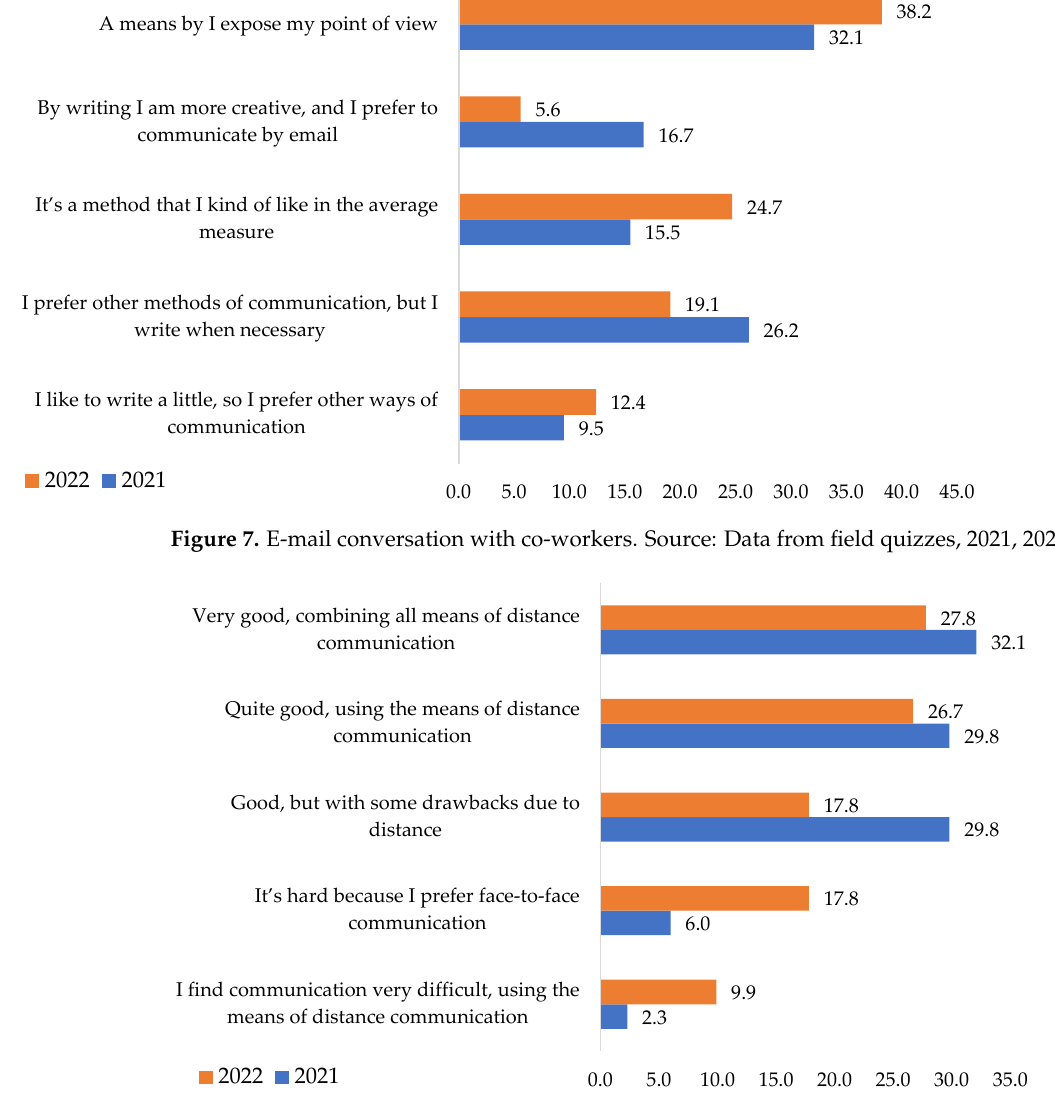
Figure 8. Co-worker’s connection during the pandemic. Source: Data from field quizzes, 2021, 2022. Conversation with co-workers remains an important issue for respondents. The research results confirmed the H4 hypothesis that during the COVID-19 period, direct communication with co-workers was different from that under normal conditions. In this case, the two variables were associated. It can be said that direct contact in labor relations is better without social distance.